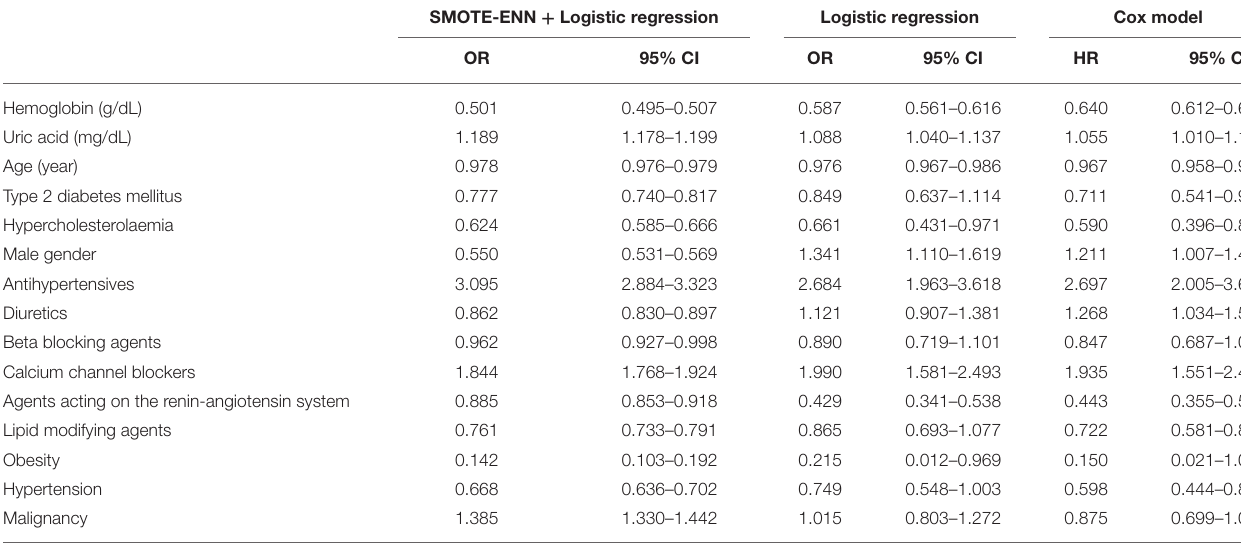
TABLE 2 | Parameter estimates of the logistic regression analysis and the Cox proportional hazards model to predict the risk of future progression to